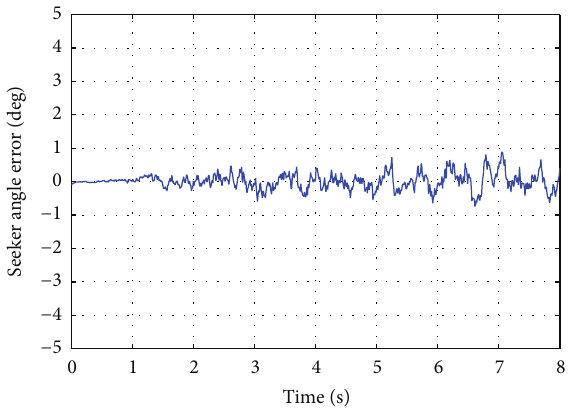
Figure 9: Error for gimbaled system (Case 1).